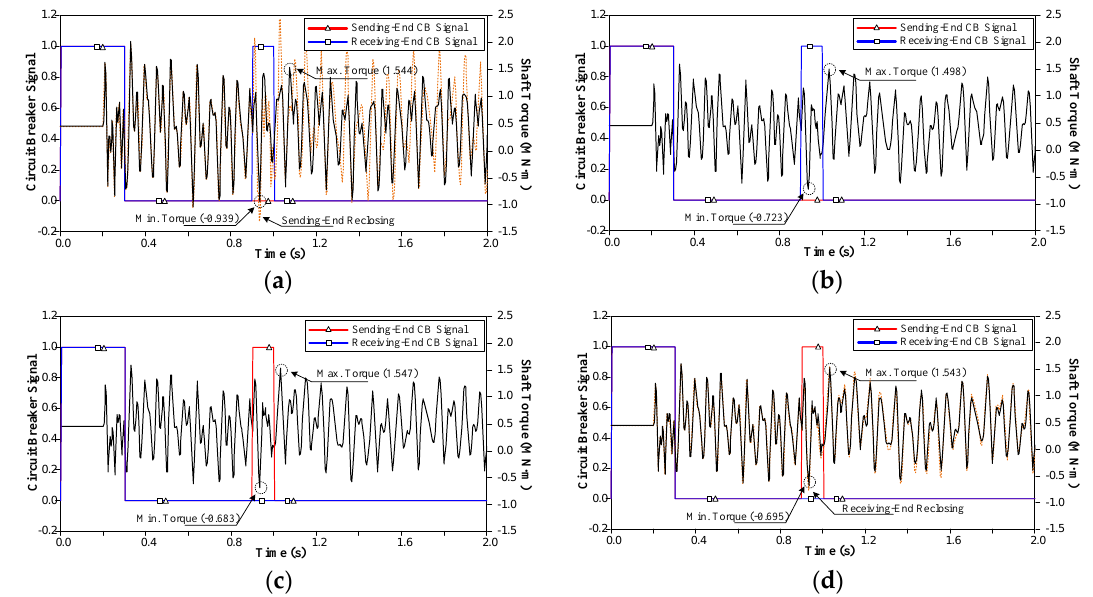
Figure 8. Circuit breaker operation signal and instantaneous shaft torque waveform: ( a ) for case 6-1 (10% of T/L #6); ( b ) for case 6-2 (87% of T/L #6); ( c ) for case 6-3 (88% of T/L #6); ( d ) for case 6-4 (90% of T/L #6).